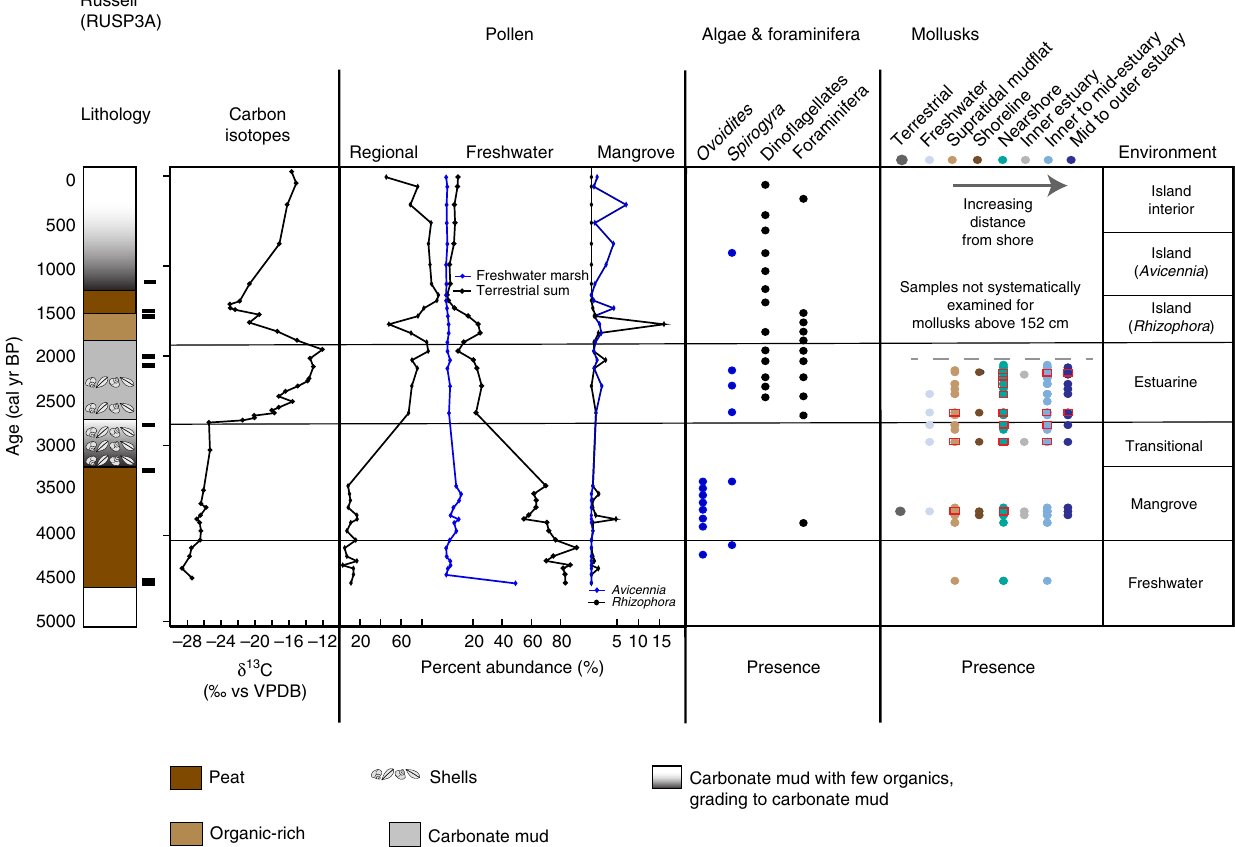
Fig. 3 Core summary diagram for Russell Key (RUS). Carbon isotopes, selected pollen groups, and presence of algal cysts, foraminifera and dino fl agellates, and mollusks. Regional pollen includes Pinus (pine) and Quercus (oak). Freshwater marsh sums include Poaceae, Cyperaceae, Nymphaea, Typha, Rhynchus, Cladium, Schoenoplectus, Sagittaria, Crinum , and Amaryllidaceae. Terrestrial sum includes all taxa, except the regional taxa and mangrove taxa, as well as Batis maritima and Amaranthaceae. Presence of certain taxa include Ovoidites , Spirogyra (closed blue circles); dino fl agellates, foraminifera (black closed circles). Mollusk presence is shown in order of increasing salt-water/estuarine habitat and distance from shoreline from left to right. Red squares indicate abundance or dominance in a given sample. Radiocarbon age control shown by black rectangle next to the